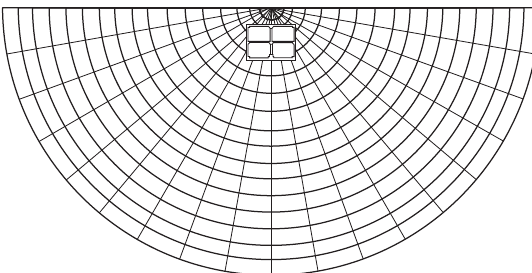
Figure 8: Schematic representation of the time history analysis calculation